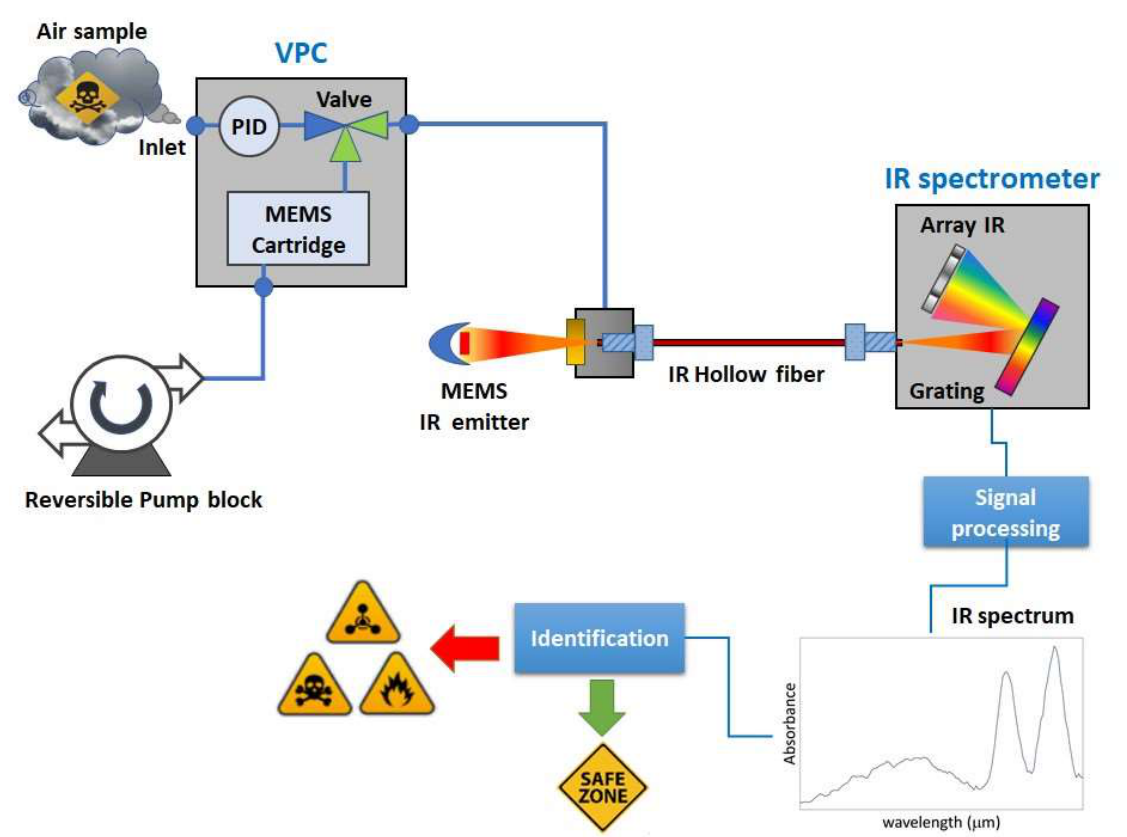
Figure 1. Concept design of the LIRAS sensor.